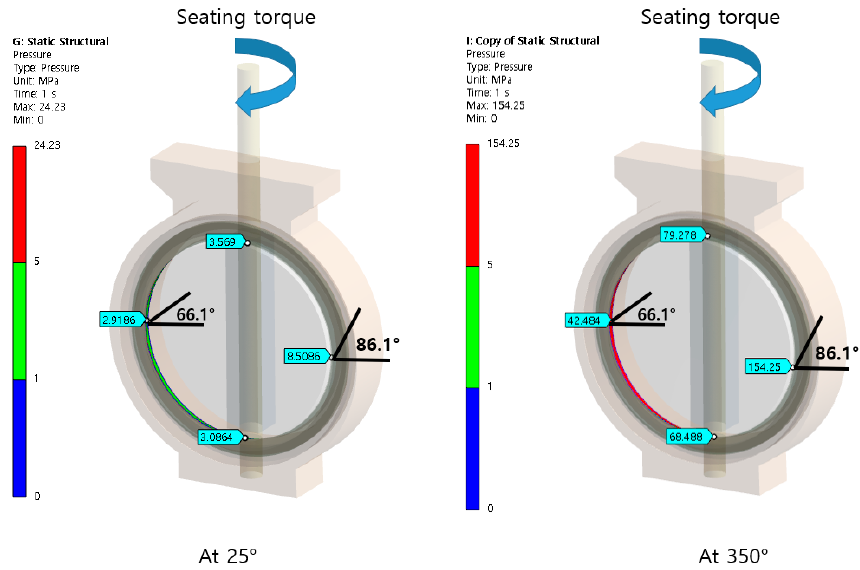
Figure 16. The contact pressure distribution of the three-layers model. The contact pressures of the five-layers at the angles of 86.1 ◦ and 66.1 were 2.87 MPa and 8.25 MPa at 25 ◦ C, and 14.37 MP and 89.8 MPa at 350 ◦ C, as shown in Figure 17. The maximum contact pressure was 114 MPa at 350 ◦ C, leakage was not found, and compared with the three-layer model at 350 ◦ C, the max contact pressures were reduced by 40